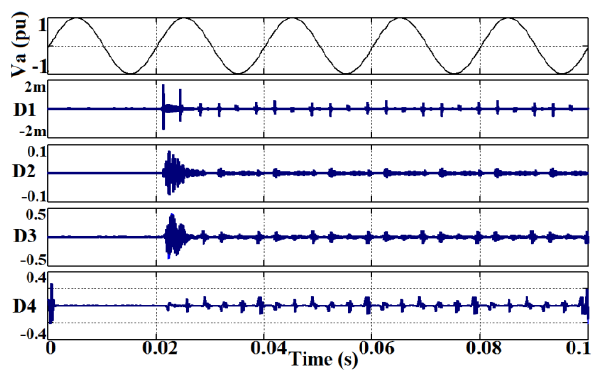
Figure 12. DWT details for thyristorload.